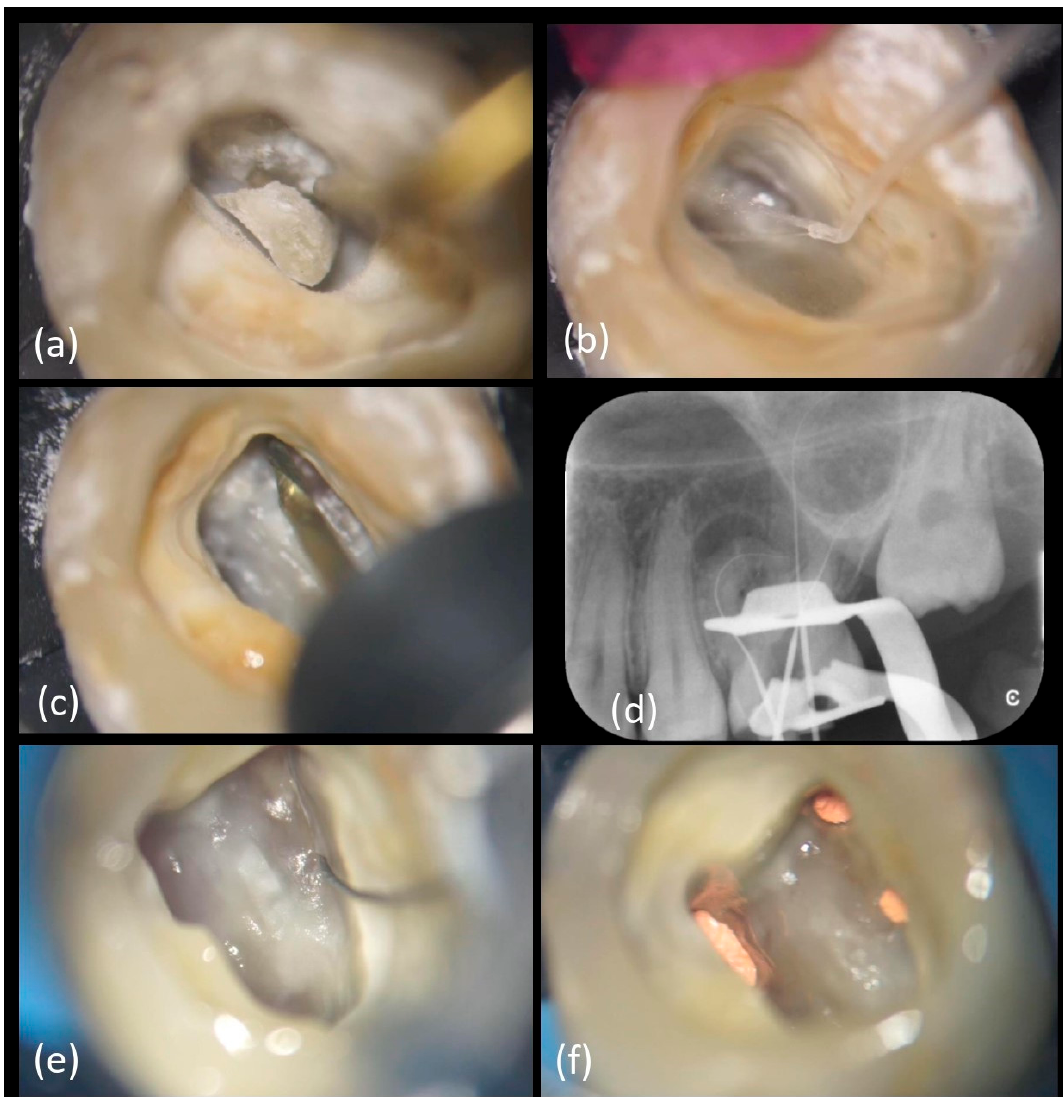
Figure 8. Main clinical steps of case 2. ( a ) Access cavity with US tips, ( b ) chamber irrigation with IrriFlex ® , ( c ) orifices enlargement with TruNatomy™ Orifice Modifier followed by the TruNatomy TM series, ( d ) working lengths X-ray control, ( e ) MB2 location and ( f ) filling with bioceramic sealer and single cone gutta-percha